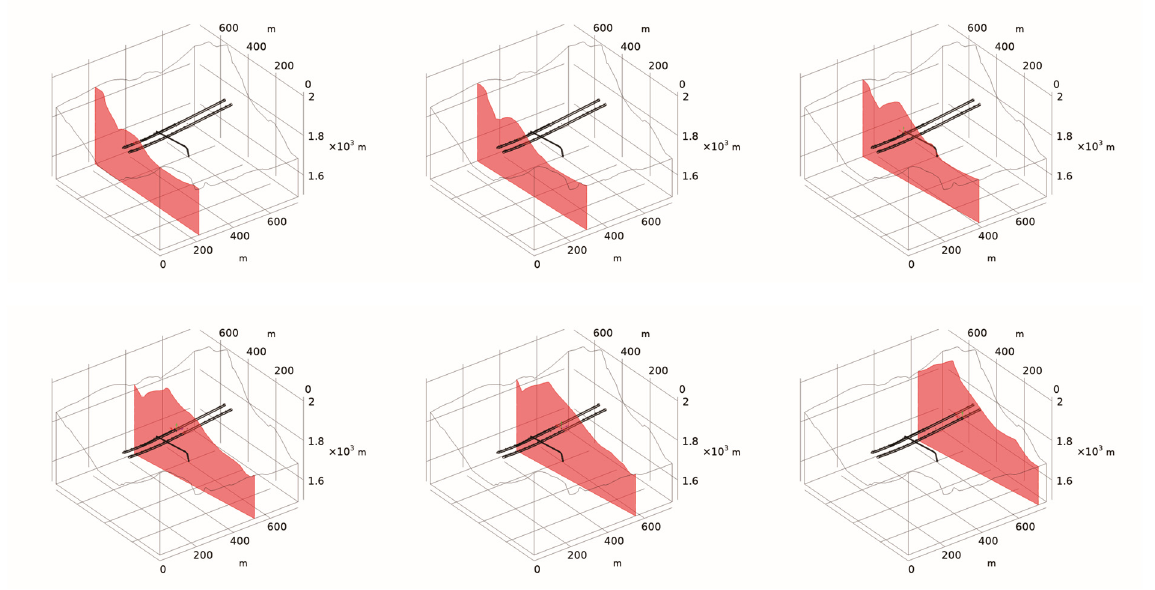
Figure 13. Positions of each section in the 3D calculation model of working condition 3.